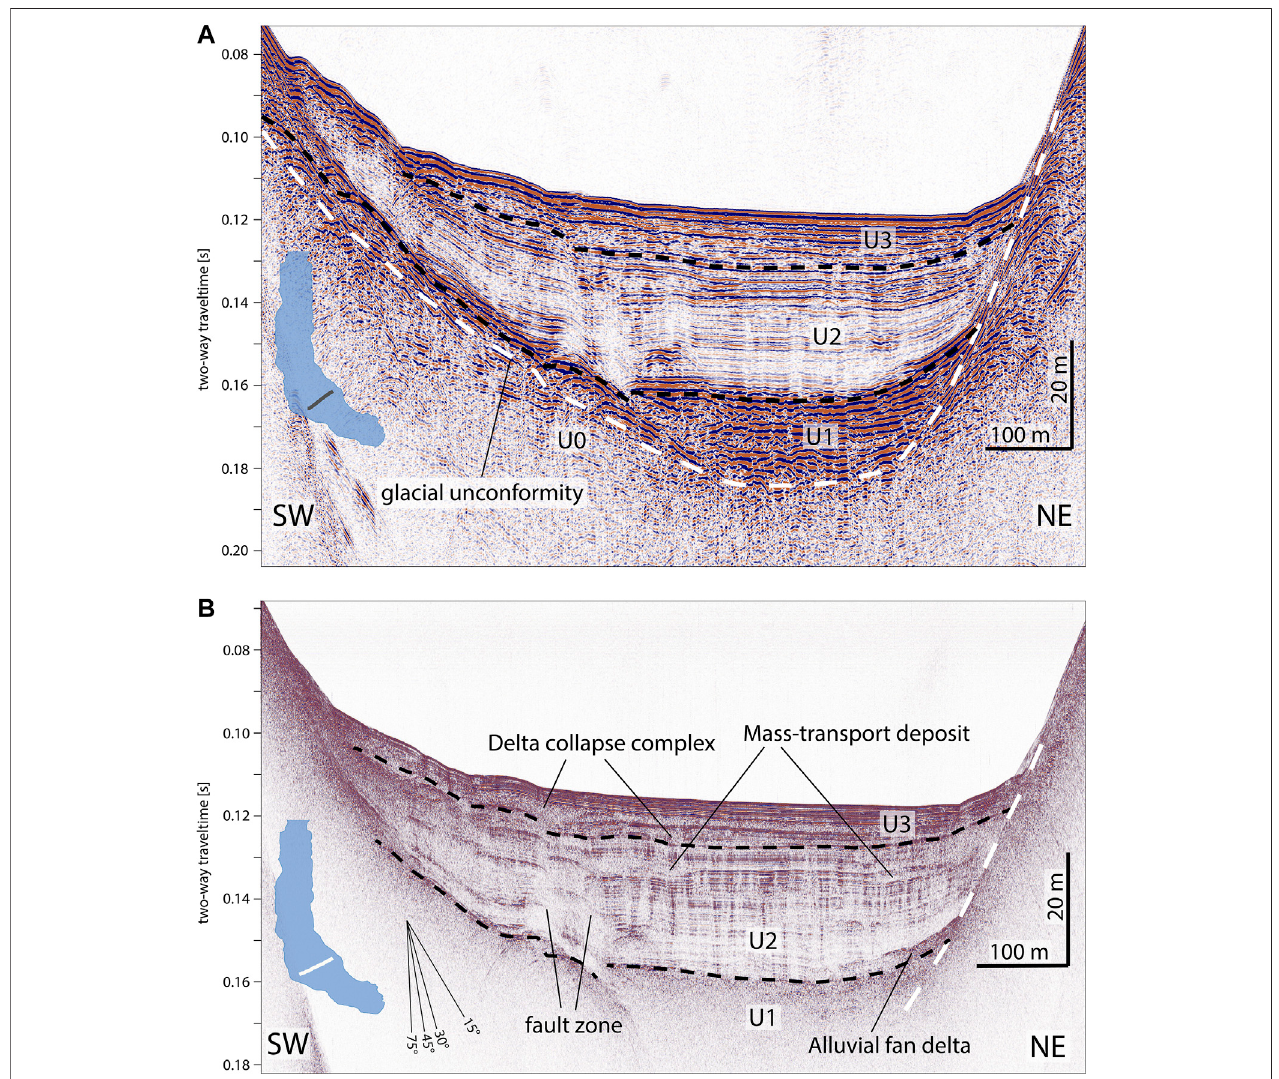
FIGURE2| Seismicpro fi lesacrossthePertisaubasinusinganintermediate-frequencysparkersource (A) andahigh-frequencypingersource (B) . (A) Thesparker pro fi le images the whole post-glacial sedimentary in fi ll subdivided in three seismic units (U1 – U3; black dashed lines) onlapping the glacial unconformity (white dashed line). (B) The pinger pro fi le accurately resolves wedge-shaped mass-transport deposits and a delta collapse complex intercalated in U2 and U3. Vertical blurred fault zones offset the sedimentary in fi ll.